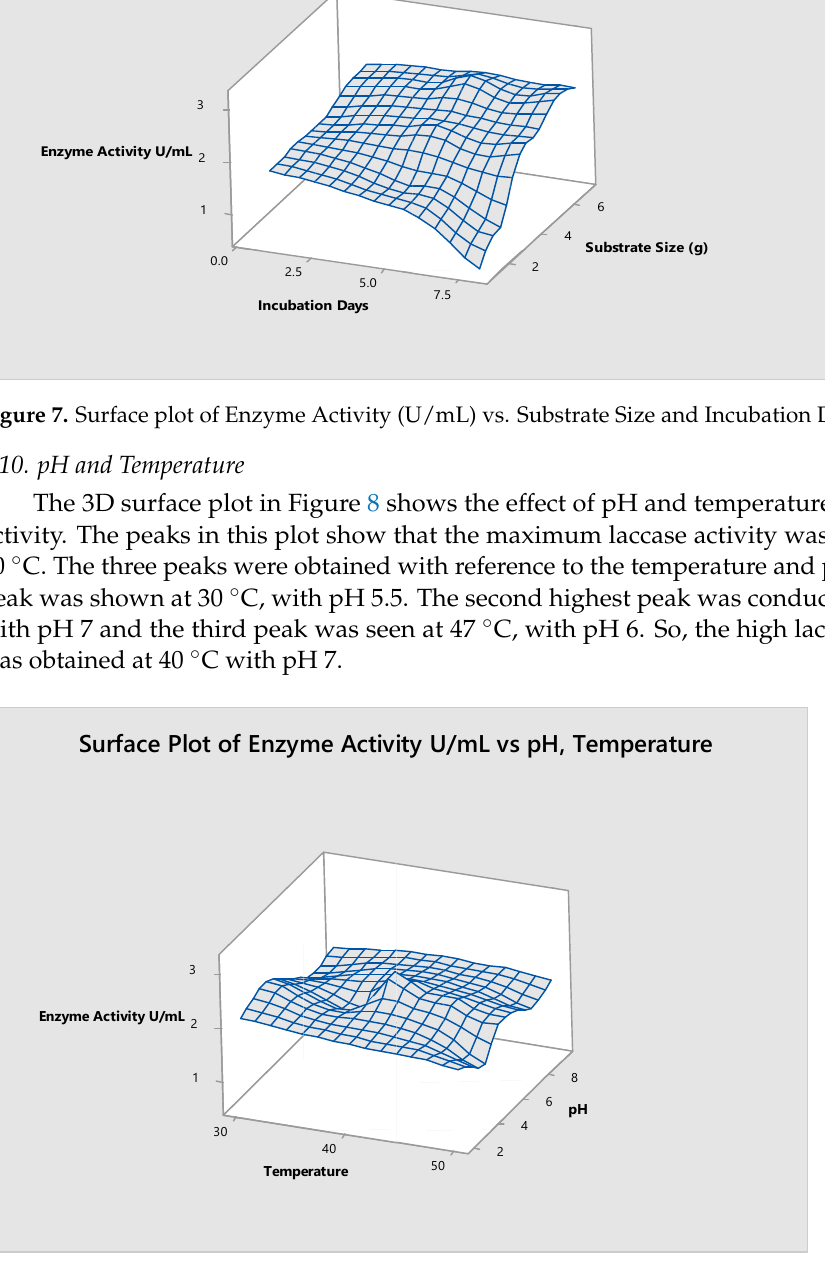
14 of 20 Figure 6. Surface plot of Enzyme Activity (U/mL) vs. Substrate Size and Moisture Level. 3.9. Substrate Size and Incubation Days This 3D surface plot indicates the effect of incubation time and substrate size on enzyme activity. The incubation time was plotted on the x ‐ axis, substrate size was plotted